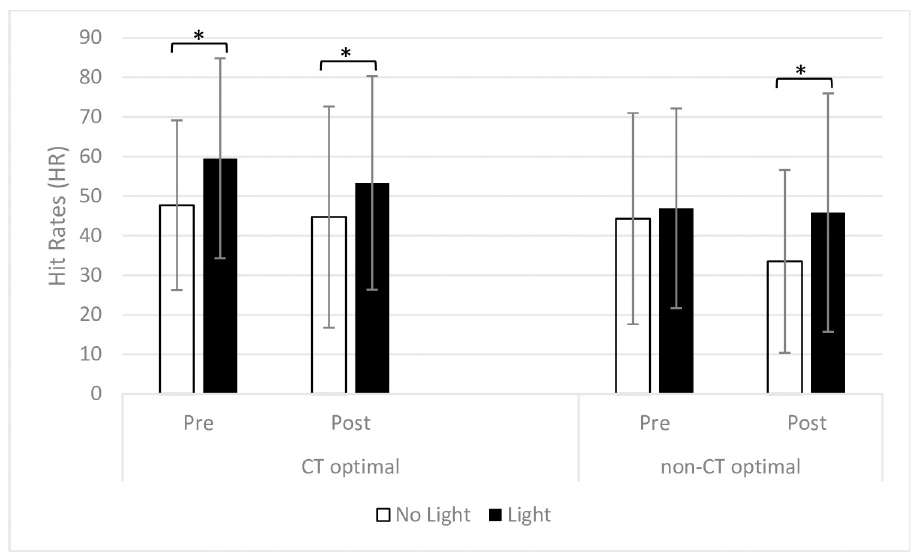
Fig 3. Mean HR during the SSDT in Light and No Light trials before (Pre) and after (Post) receiving the touch manipulation in the CT optimal and non-CT optimal group. Error bars show standard deviations. For the CT optimal group there was an effect of the light during the first (Pre) and the second repetition (Post) of the SSDT. For the non-CT optimal group an effect of the light was found only during the second repetition (Post). light only after the touch manipulation. Therefore the correction for baseline scores did not change this effect. No significant results were found in the CT optimal group resulting from the fact that the effect of the Light before and after the touch manipulation remained fairly sta- ble. No other significant results were found (all ts � 1.38; all ps � .17). Results are reported in Fig 3. 3.3.2 False Alarms (FA). A Friedman’s test showed that there was a significant difference in FA in at least one of the four experimental conditions (Light × Time) in the CT optimal group (X 2 (3) = 19.32, p = .000, W = .20). Post-hoc tests using Wilcoxon signed-rank test showed that in the CT optimal group there was a significant effect of Time with lower FA after the touch manipulation (Post; Mdn = 4.50) as compared to before it (Pre; Mdn = 8.90; z = -2.52, p = .012, r = .45), indicating that receiving CT optimal touch decreased subsequent false reports of the tactile pulse during the SSDT. No other significant within-subjects effects were found in the CT optimal group (all zs � -1.85, all ps � .064). Regarding the non-CT optimal group, a Friedman’s test showed that there was a tendency towards a significant difference in FA between the four experimental conditions (Light × Time; X 2 (3) = 7.58, p = .056, W = .07). However, follow up analyses showed no within-subjects effects to be significant (all zs � -1.86, all ps � .083). Mann-Whitney tests revealed a significant between-groups difference in FA in the change score between Pre and Post FA (before and after the touch manipulation; U = 376.50, z = -2.18, p = .029, η 2 = .07), with a stronger decrease in FA from Pre to Post in the CT optimal group ( Mdn = -2.50) as compared to the non-CT optimal group ( Mdn = .00). No other signifi- cant differences between the two groups were found ( U � 406; p � .062). Results are reported in Fig 4. 3.3.3 Sensitivity ( d’ ). Following the main hypothesis of this study, a priori analyses were planned to assess differences in d’ between the CT optimal and the non-CT optimal groups before (Pre) and after (Post) the touch manipulation. According to our expectations, results